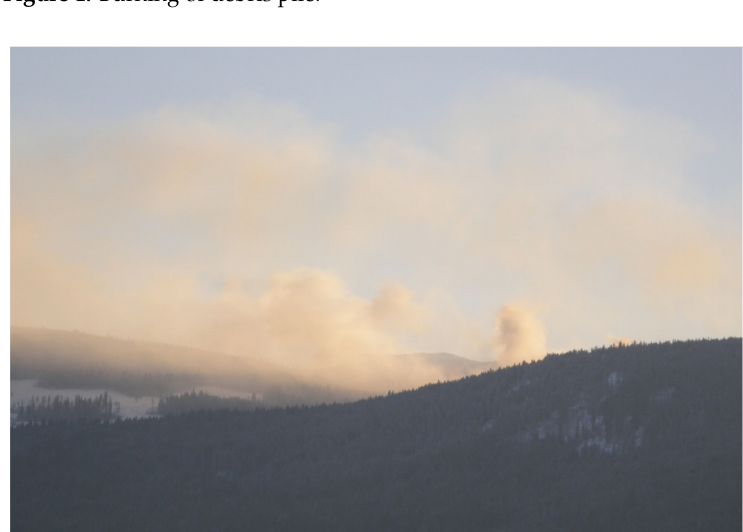
Figure 2. Smoke from burning of debris